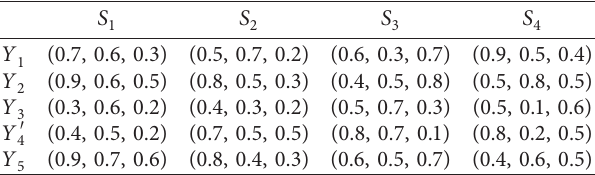
Table 9: 3F decision matrix.